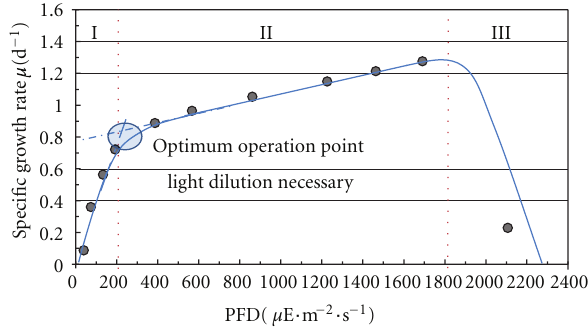
Figure 2: Specific growth rate as function of light irradiation plotted as photosynthetically active photon flux density (PFD) for Chlamydomonas reinhardtii ; 1000 µ E · m − 2 · s − 1 corresponds approx- imately to 200 W · m − 2 . The PCE can be read as gradient from the origin to a given point on the curve. Therefore, PCE is at its opti- mum only in range I, where the circle indicates the point of highest growth rate.